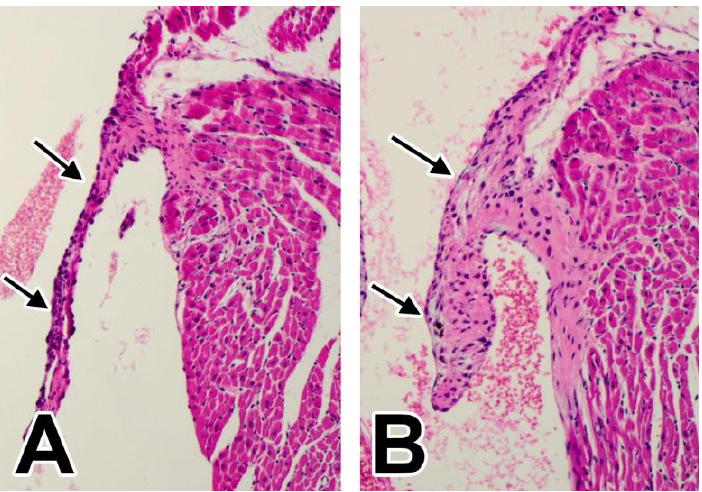
Figure 12. Myxomatous posterior leaflet in a WT1 cre ;SOX9 fl/fl specimen at one month after birth. Panel ( A ) shows an H/E staining demonstrating the posterior leaflet of a control heart, panel ( B ) shows the myxomatoyus phenotype of the posterior mitral valve leaflet, in a WT1 cre ;SOX9 fl/fl specimen.